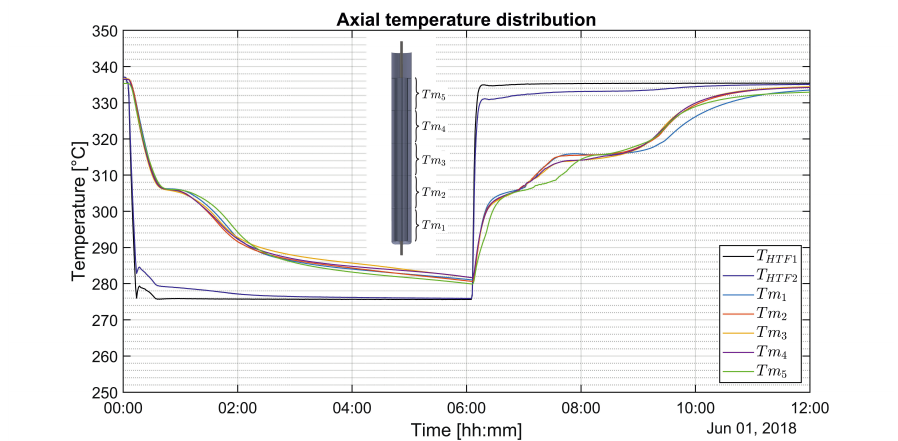
Figure 8. Axial temperature distribution in the